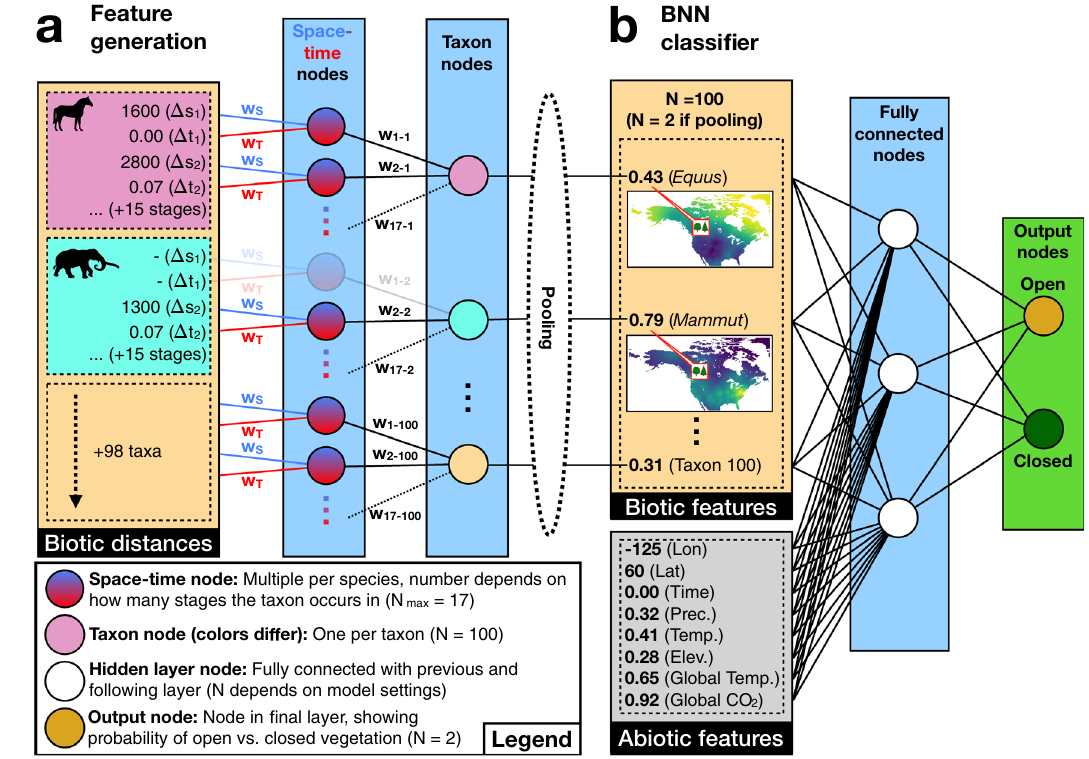
Fig. 2 | The BNN model architecture. a The spatial and temporal distances extractedseparatelyfor100mammalandplanttaxa(Fig.1),aretheinputofthe fi rst two hidden layers in the BNN model. During training, the BNN optimizes weights (represented by lines labeled with w X ) to reduce the multitude of spatial and temporal distance measurements into one single “ proximity ” value for each taxon (taxonnodes) relative to the given point inspaceand time. This process offeature generationisequivalent tothe convolutionallayersin animageclassi fi er, reducing higher-dimensionality data into lower-dimensionality features for input into the subsequentneuralnetworklayers.Insomeofourtestedmodelstheresultingtaxon